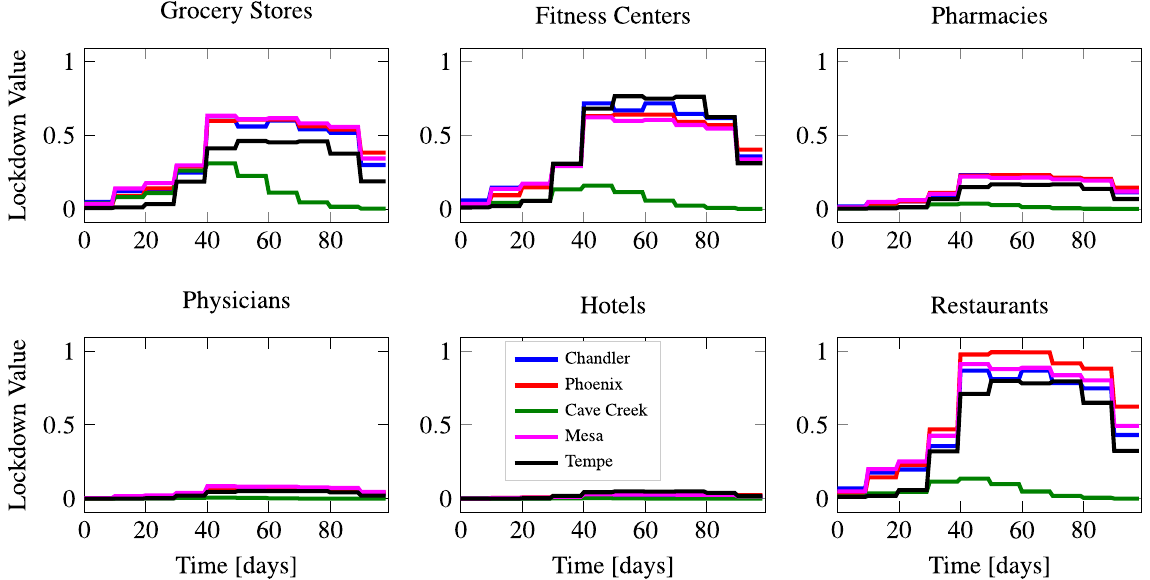
Figure 5. Visualization of the lockdown policies for different types of activity sites and for five representative subregions in the Phoenix MSA. Higher values correspond to lockdowns that are more restrictive. The 6 populations of the five representative subregions, listed in decreasing order, are: Phoenix ( 1.67 × 10 ), Mesa 5 5 5 3 ( 5.46 × 10 ), Chandler ( 2.67 × 10 ), Tempe ( 1.82 × 10 ), and Cave Creek ( 6.20 × 10 ). For all activity sites, we observe that the average lockdown value is higher for subregions with larger populations. We also note that the lockdown value is significantly higher for certain activity sites due to their large demand rates.